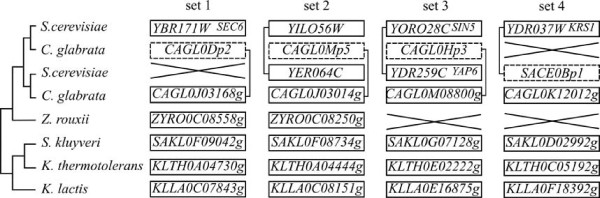
Pseudogenes in pairs of ohnologs in Saccharomycetaceae. Same legend as Figure 2. Pairs of ohnologs, i.e. paralogs originating from the whole-genome duplication [70], are linked by brackets.